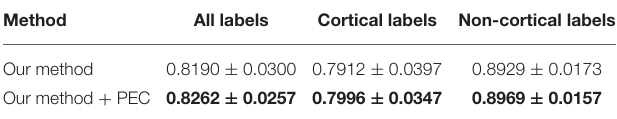
TABLE 1 | Proposed method dice results.